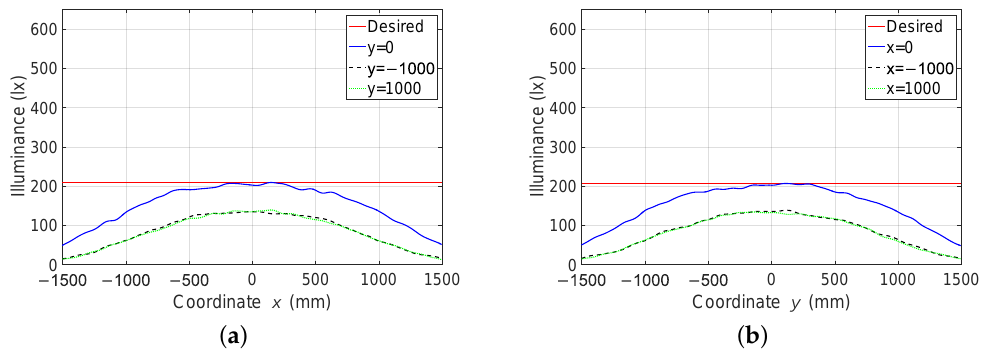
Figure 17. Illuminance distribution curves of the three profiles found using genetic algorithm: ( a ) on the coordinate axis x and ( b ) on the coordinate axis y